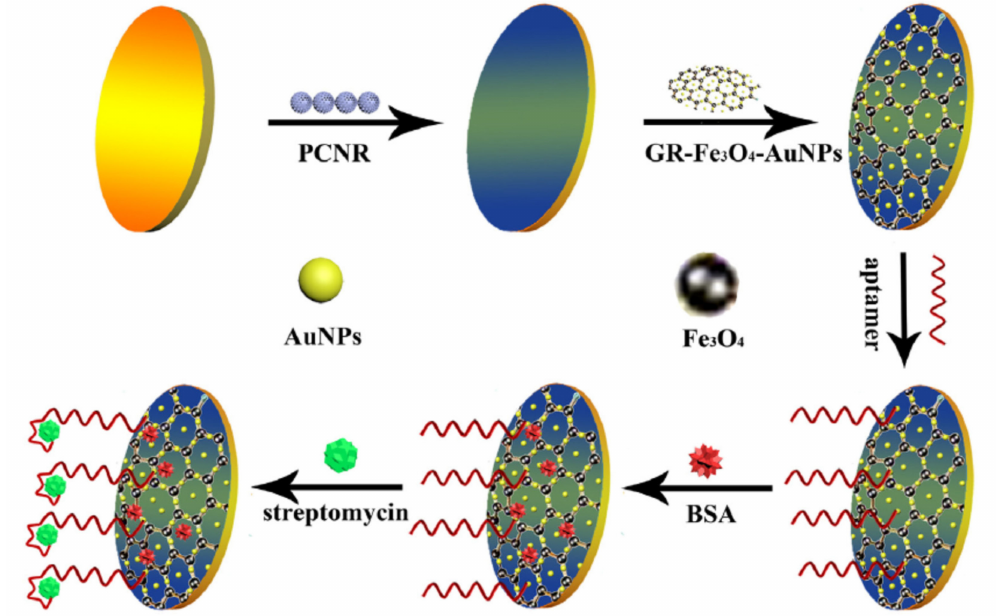
Figure 16. Schematic representation of an electrochemical aptasensor for the detection of streptomycin based on the porous carbon nanorods and multifunctional graphene nanocomposites. Reprinted from reference [77] with permission from